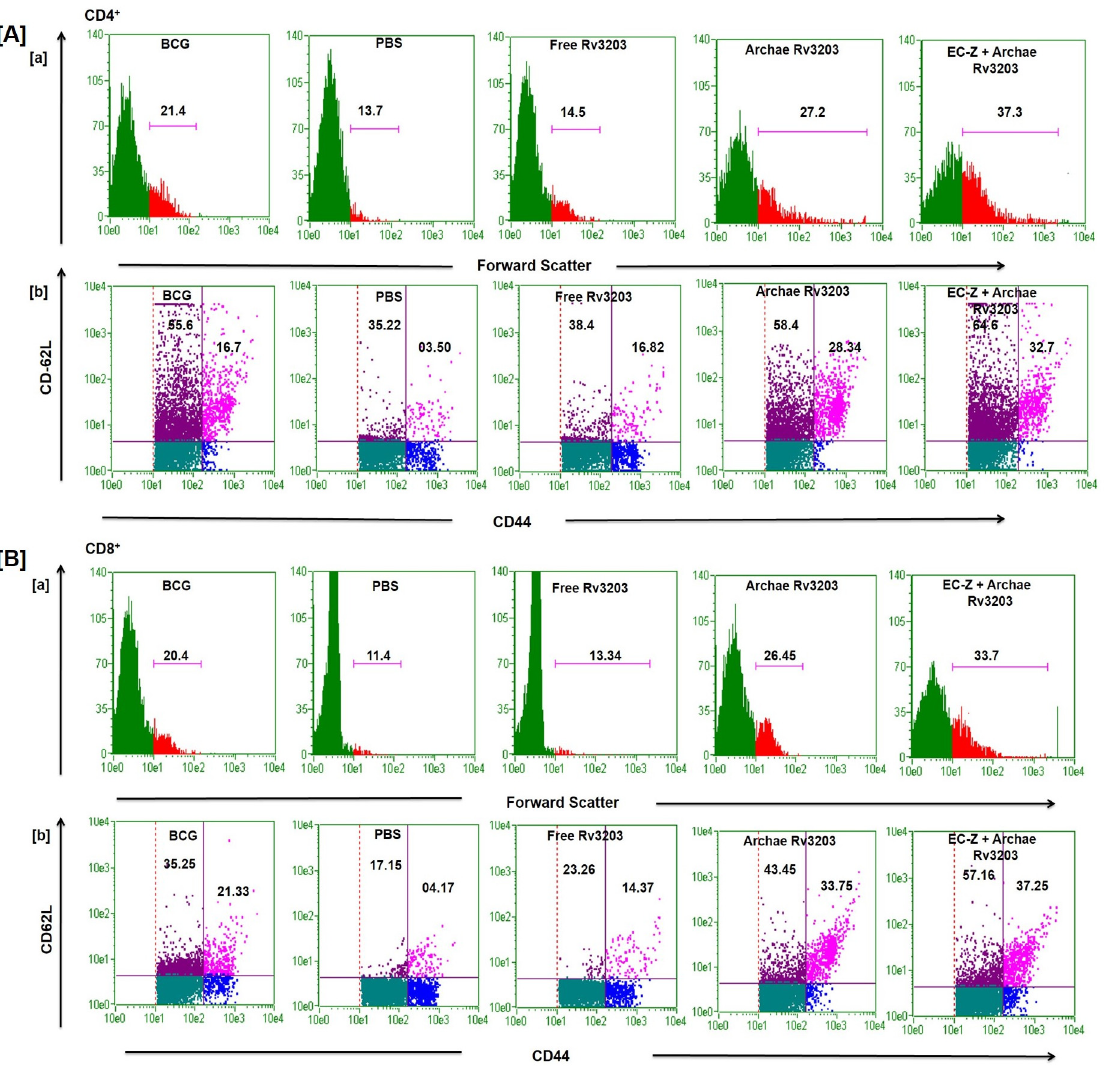
Fig 4. Immunization of mice with archae-Rv3203 augments long-lasting cell memory response. Splenocytes were isolated from various immunized groups after 8 weeks post challenge and analyzed for the presence of CD44 high CD62L low/high on gated CD4+ and CD8 + T cells by FACS (A) and (B) respectively. Data represent mean ± SD from three independent experiments. Statistical significance was determined as described in materials and methods. p (cid:1) 0.05, p < 0.01, p < 0.001 and p > 0.05 represented as ( * ), ( ** ), ( *** ) and (NS) respectively.